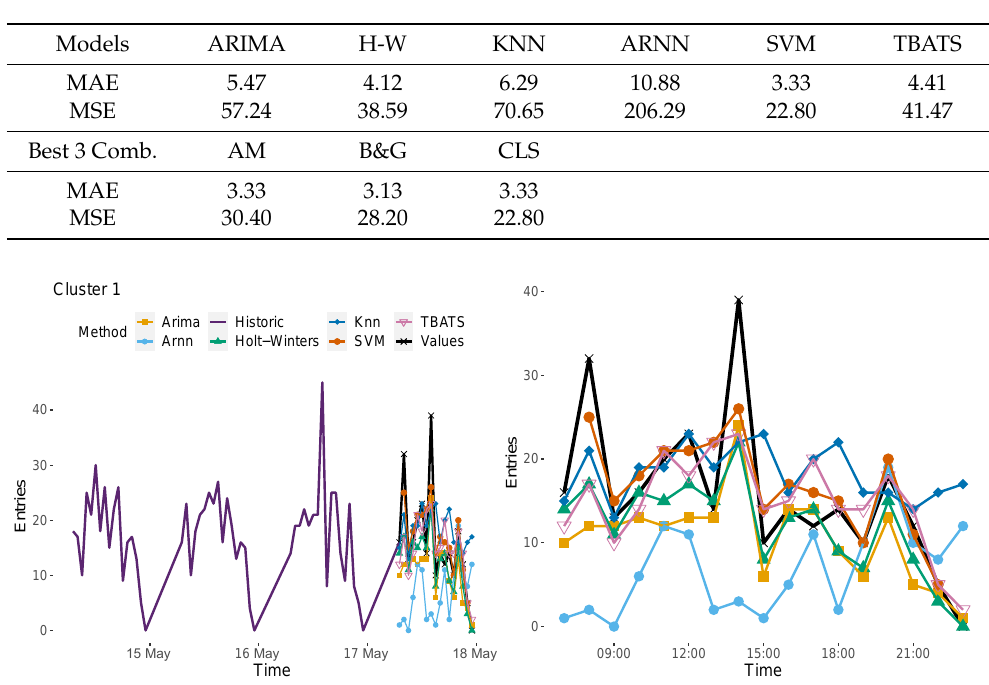
Figure 8. Cluster 1: two last days of historical data plus one-day predictions and real values ( left ). On the ( right ), a close-up of the predictions and real values is shown.